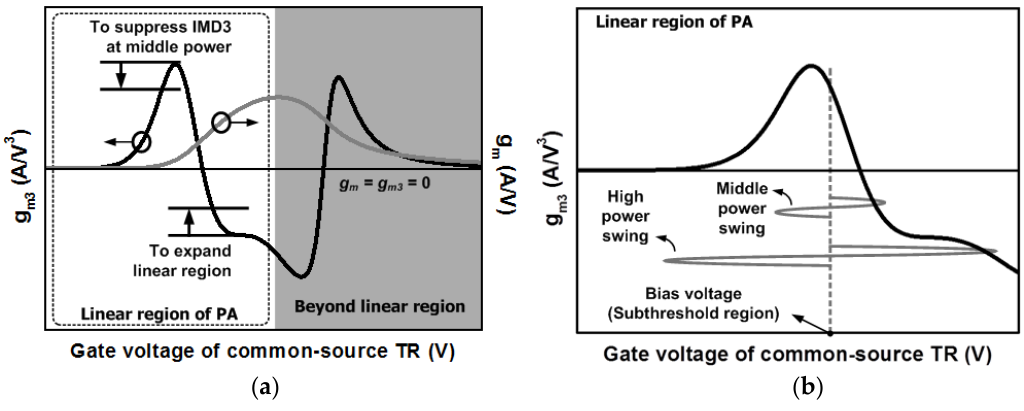
Figure 3. Conceptual diagram of g m3 of driver stage: ( a ) g m 3 , ( b ) zoomed-in g m 3 .